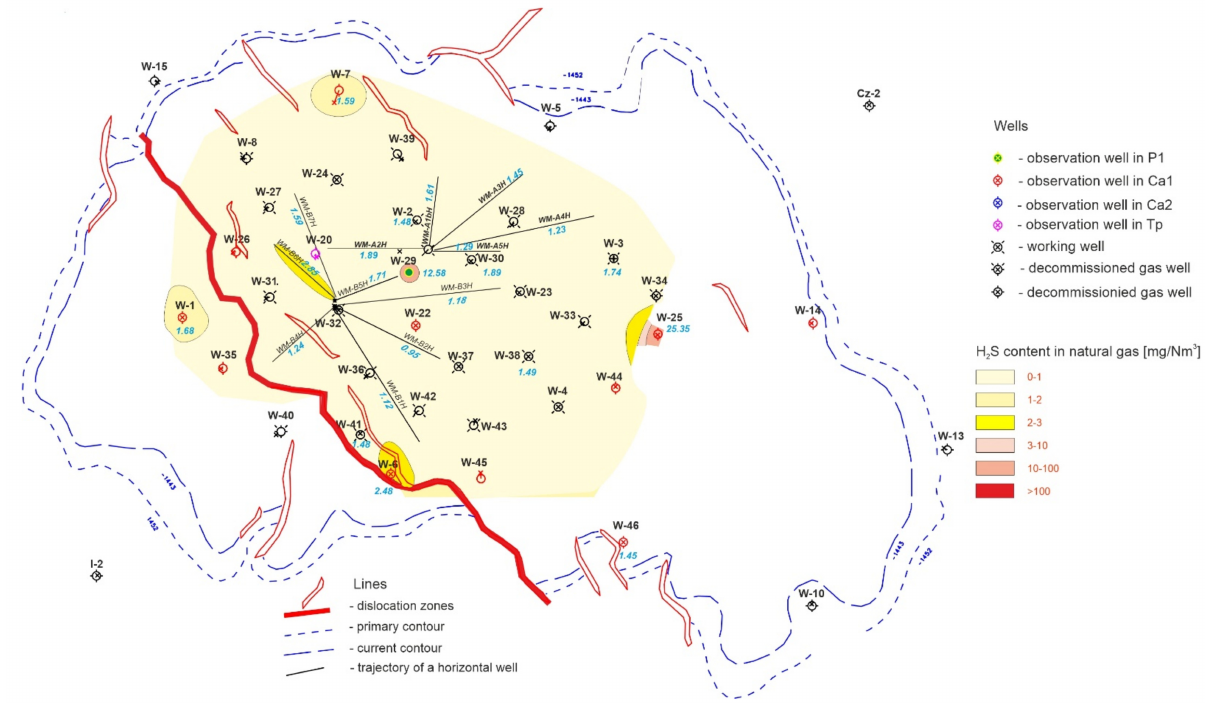
Figure 10. Map of the distribution of hydrogen sulphide content in natural gas from individual wells of the Wierzchowice Underground Gas Storage facility (series III, cycle